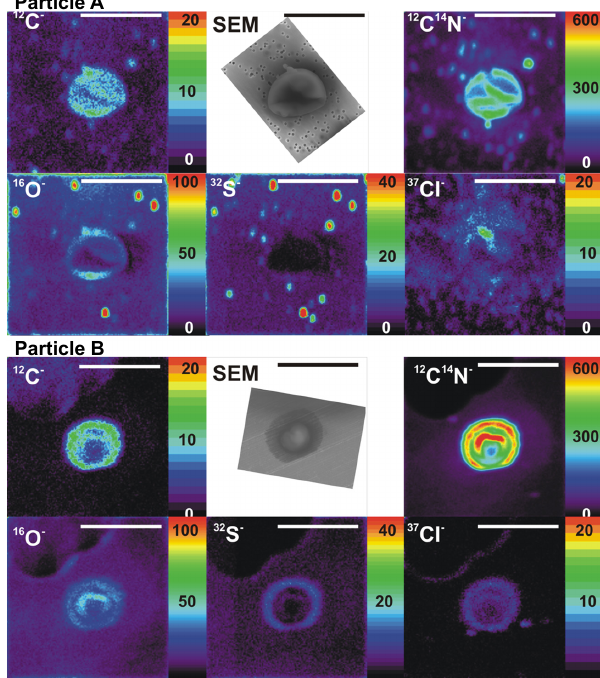
Fig. 12. SEM and NanoSIMS images of two example particles. Par- ticle A (top two rows): uncoated PBAP. Particle B (bottom two rows): coated PBAP. Black and white image shows SEM micro- graph of each particle. Colored images show map of particle, col- ored by intensity of concentration of respective elemental ions. Both particles collected during the period of low dust and biomass burn- ing pollution. Units are arbitrary, but scaled the same between each pair of elements. Scale-bar is 5µm in